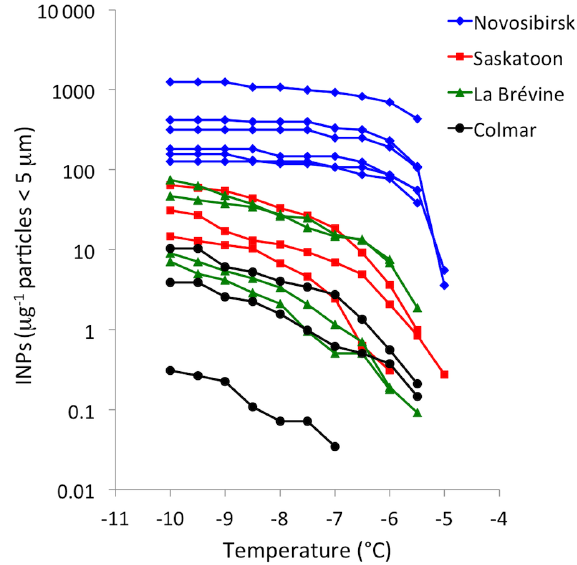
Figure 1. Ice-nucleating particles with characteristics of macro- molecules released by certain fungi as a function of the total num- ber of INPs active at − 10 ◦ C in soil particles <5µm. The trend line was fitted to all data in the plot. Not plotted are four samples from tropical Ranau (INP − 10 <0.1µg − 1 ) and one (of three) from the wine-growing area around Colmar (INP − 10 = 0 . 3µg − 1 ) in which we could not detect any INPs resembling macromolecules released by fungi.